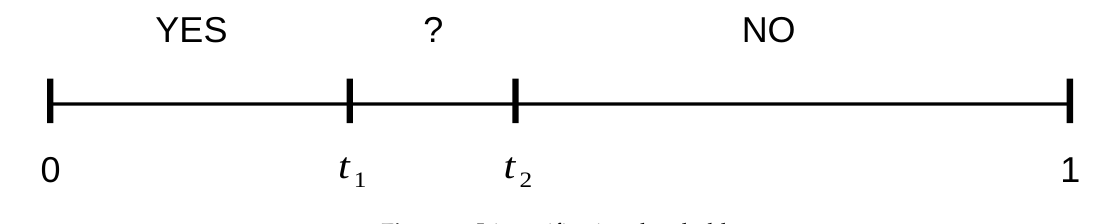
Figure 3. Iris verification thresholds.